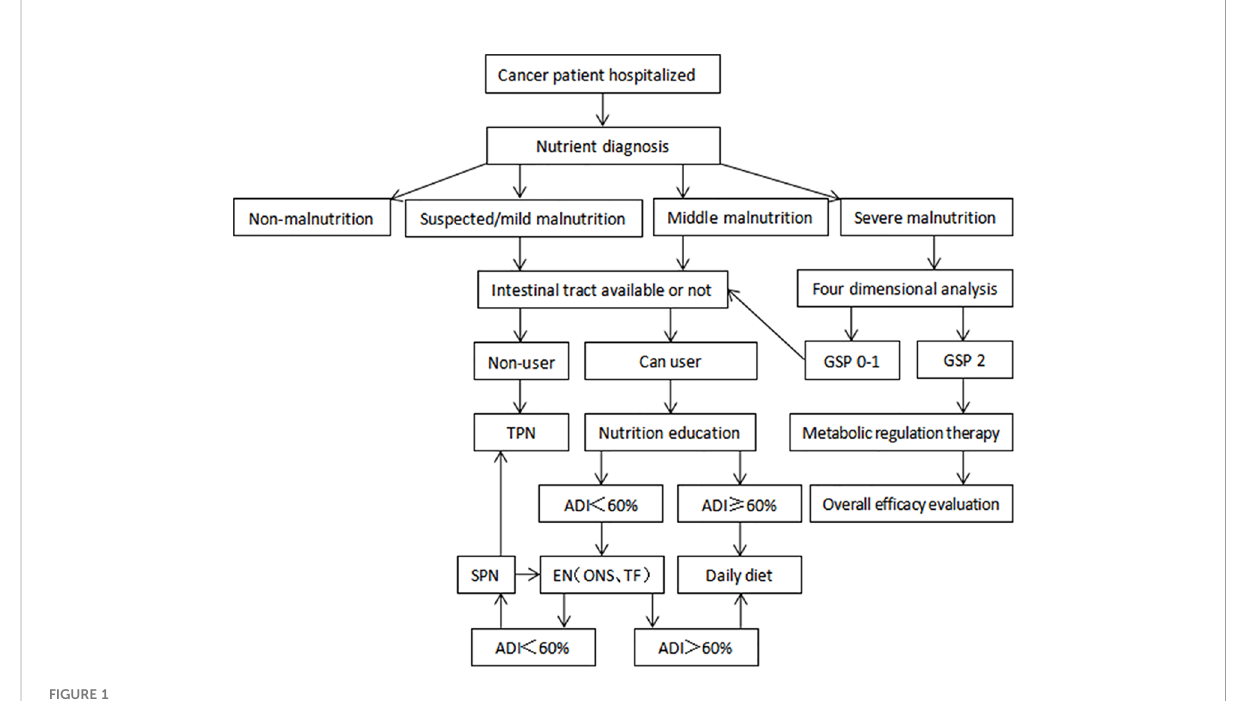
FIGURE 1 The fl ow chart of nutrition therapy for patients with